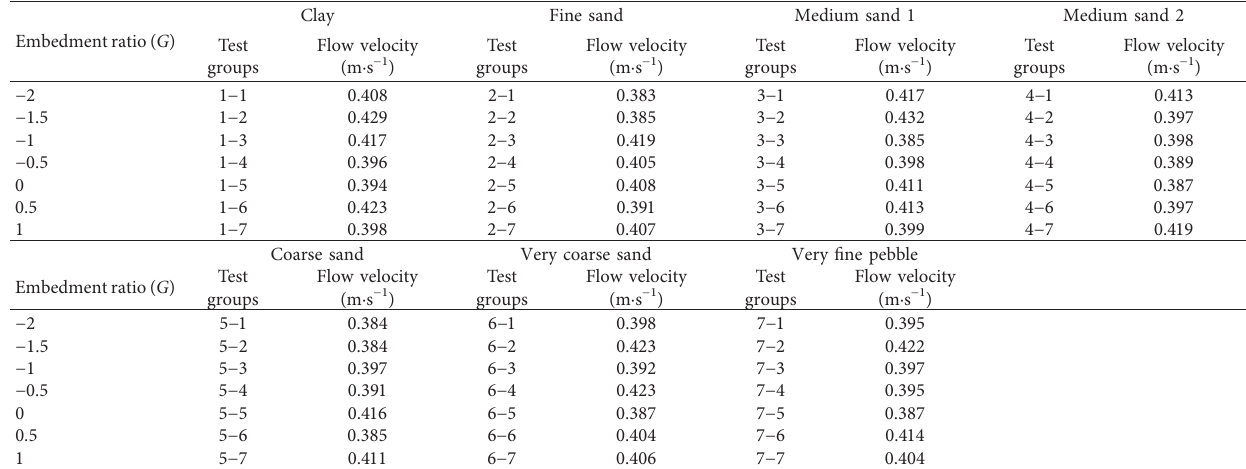
Figure 6: Schematic diagram of different embedment ratio tests: (a) schematic diagram of the test setup when the embedment ratio is − 2, (b) schematic diagram of the test setup when the embedment ratio is − 1.5, (c) schematic diagram of the test setup when the gap ratio is − 1, (d) schematic diagram of the test setup when the embedment ratio is − 0.5, (e) schematic diagram of the test setup when the embedment ratio is 0, (f) schematic diagram of the test setup when the embedment ratio is 0.5, and (g) schematic diagram of the test setup when the embedment ratio is 1. Table 3: Test